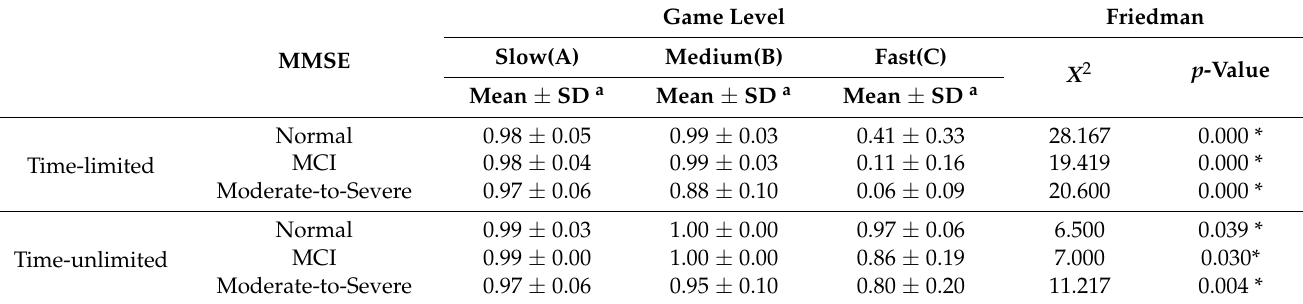
Table 5. Posterior comparisons of different speeds based on test scores using a Friedman